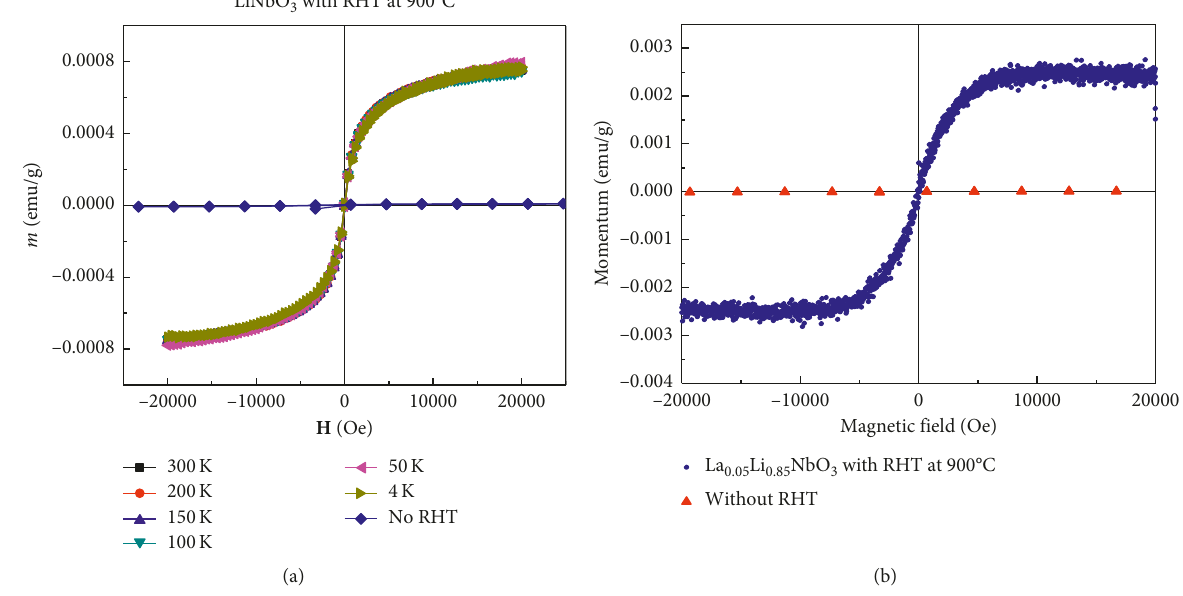
Figure 6: Multiferroic properties; magnetic hysteresis loop: (a) LiNbO